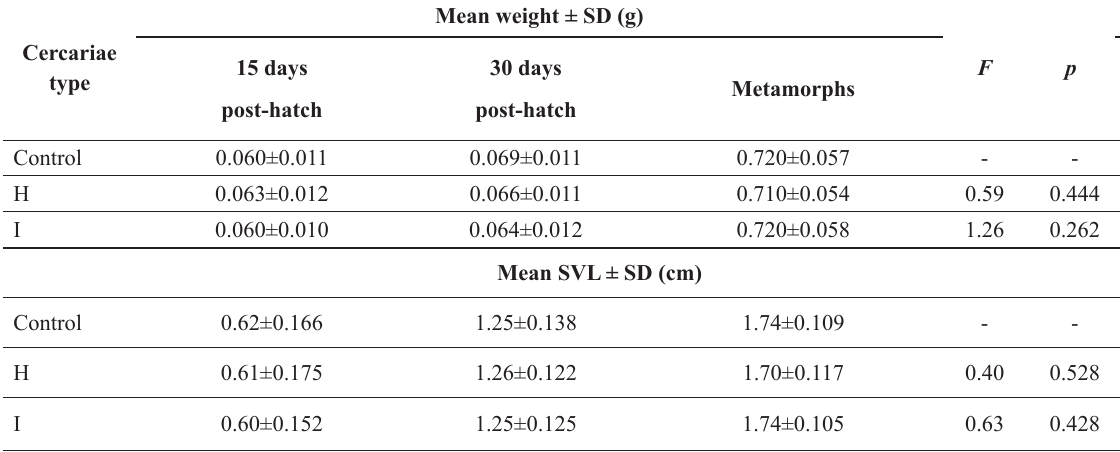
Table 2: Growth of tadpoles measured as body weight and snout to vent length of Polypedates cruciger at 15 days, 30 days post– hatch and at metamorphosis after multiple exposure to cercariae types H and I (exposure at Gosner stage